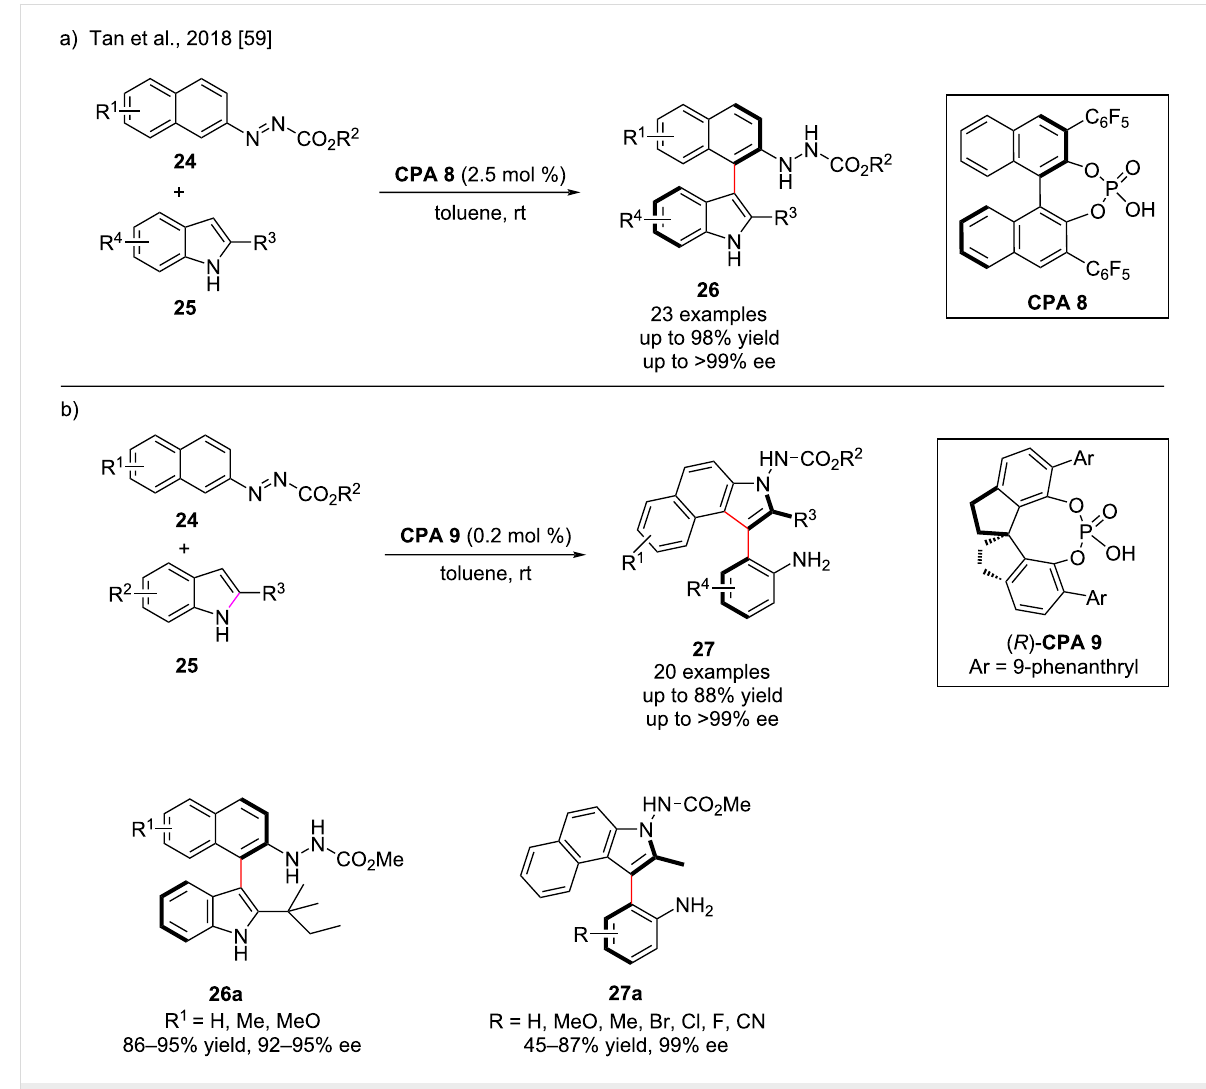
Scheme 9: Asymmetric arylation of indoles enabled by azo